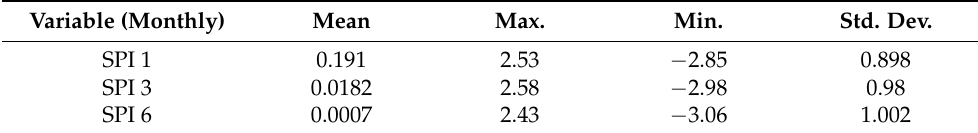
Figure 1. Shows the wind speed minimum: ( A ) monthly time series and ( B ) boxplot. Table 1. The descriptive statistics of SPI time series.